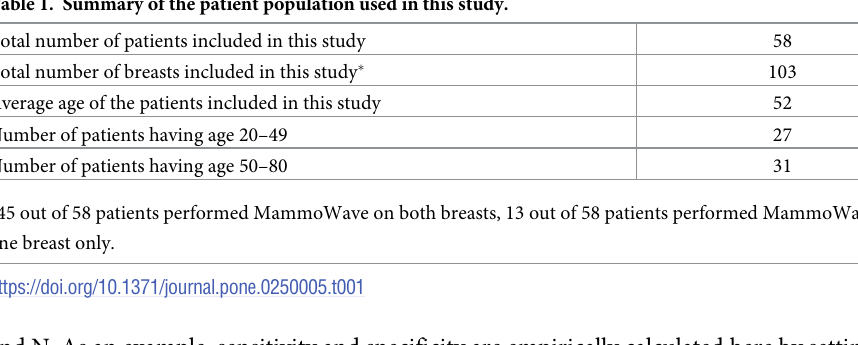
Table 2. Summary of radiological study review for the breasts considered in this study. NF breasts 52 (19) WF breasts 51 (22) In the brackets, the number of dense breasts, i.e. ACR C and ACR D, is